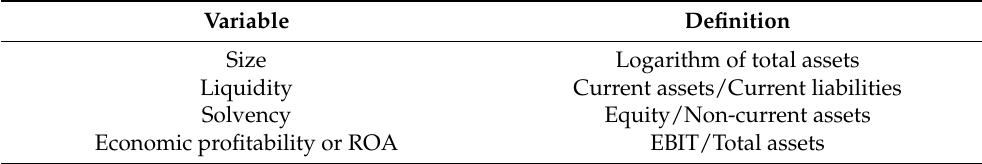
Table 7. Definition of control variables.